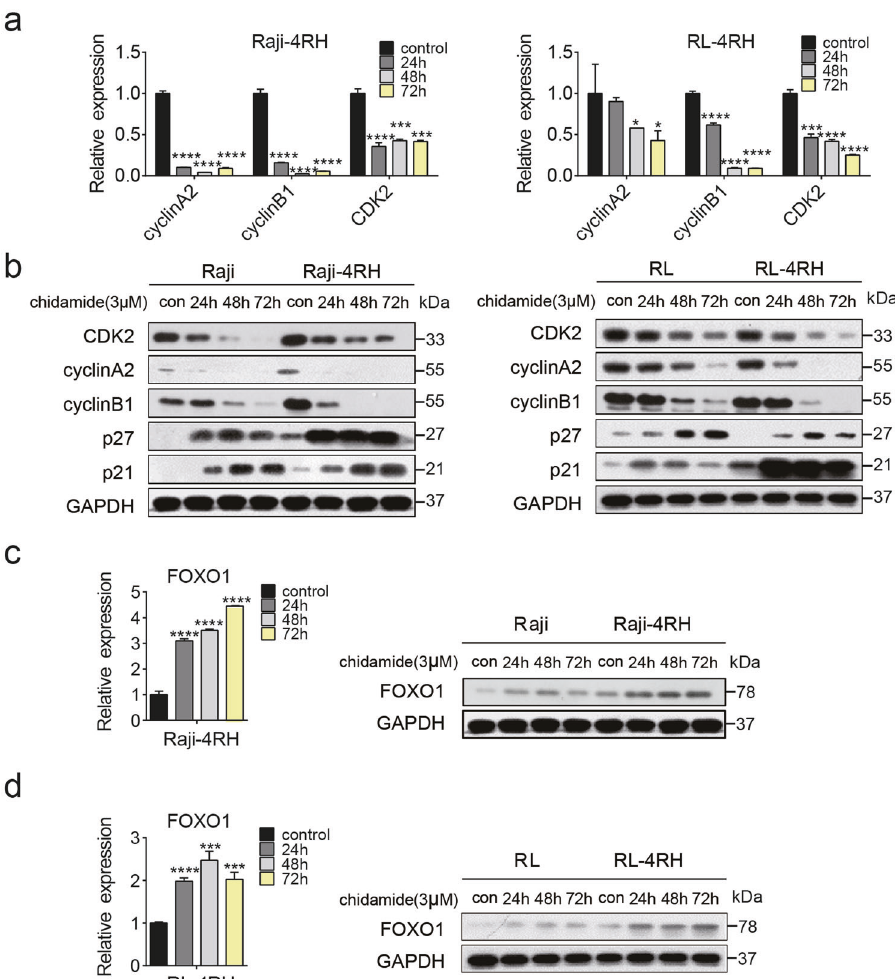
Fig. 4 Upregulation of FOXO1 and changes of cell cycle-related proteins induced by chidamide treatment. a , b Changes of p21, p27, CyclinA2, CDK2, and CyclinB1 were examined by Q-PCR and Western blot analysis in RRCL treated with chidamide (3 μ M) for 24, 48 or 72 h ( N = 3). c , d Changes of FOXO1 were examined by Q-PCR and Western blot in RRCL treated with chidamide (3 μ M) for 24, 48, or 72 h ( N = 3). For all graphs, data are presented as mean ± SD, * p < 0.05, ** p < 0.01, p < 0.005***, p < 0.001****. Statistical analysis was performed with a paired t 72 h. Chidamide treatment upregulated the amount of p21 and p27 mRNA (Fig. 3c right panel and Fig. S3a), and downregulated